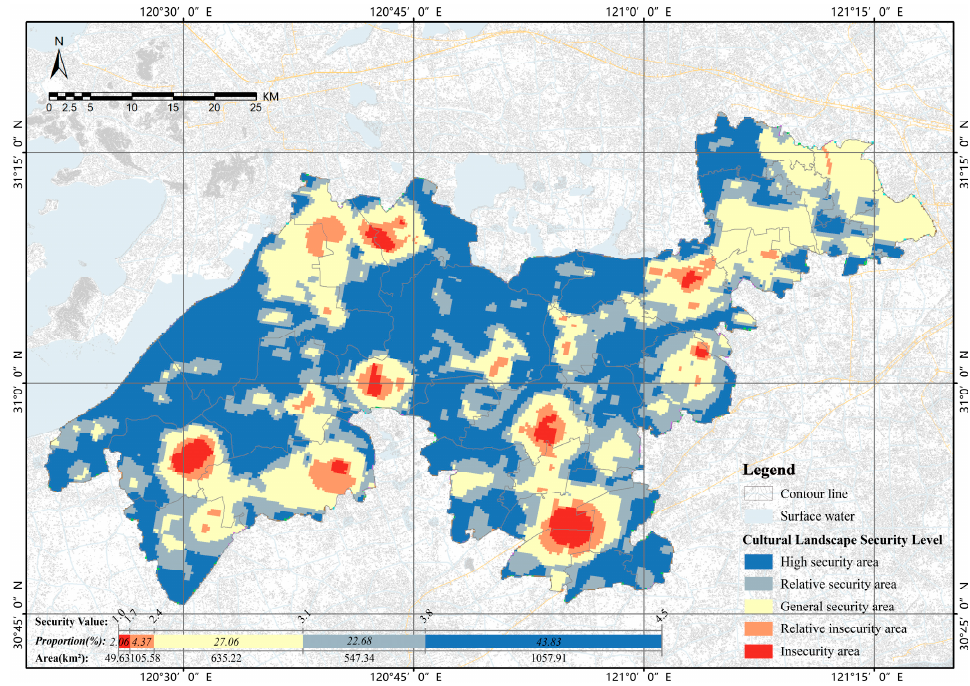
Figure 10. Result of vernacular cultural landscape security pattern in the demonstration area.